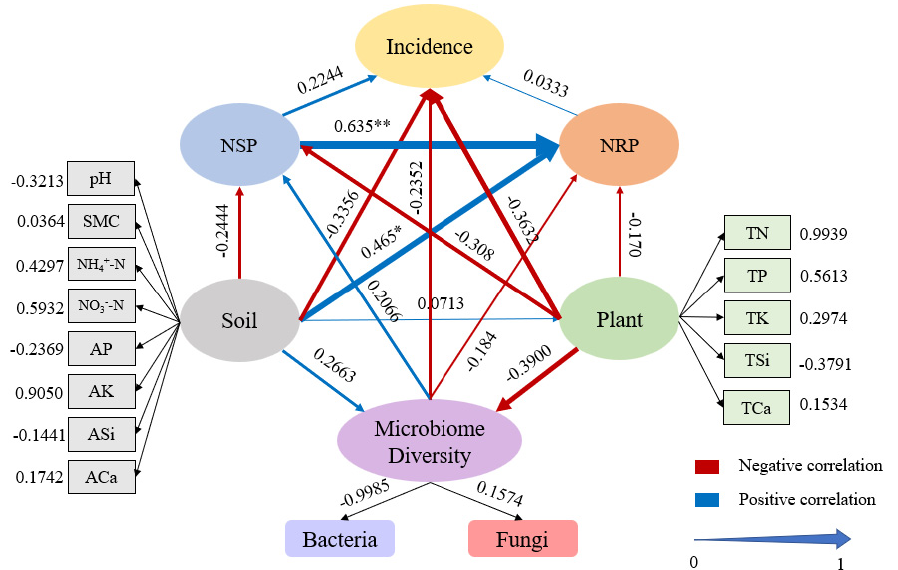
Figure 8. The least partial squares path analysis between the soil microbial community, soil and plant physicochemical properties (SMC, AN, NN, AP, AK, ASi, ECa, TN, TP, TK, TSi, TCa), soil and root pathogen numbers (NSP, NRP), and disease incidence. Solid lines represent significant correlations and dashed lines represent insignificant ones. Red lines represent negative interactions between two nodes, while blue lines represent positive interactions. p * < 0.05, p ** <